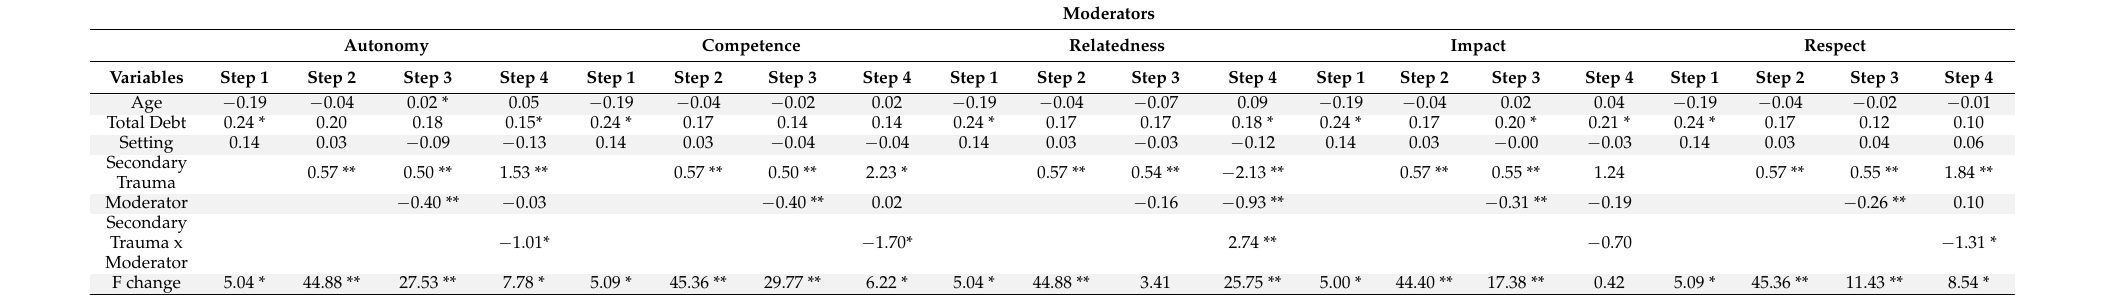
Table 4. Associations between job resources and secondary trauma with regard to burnout.